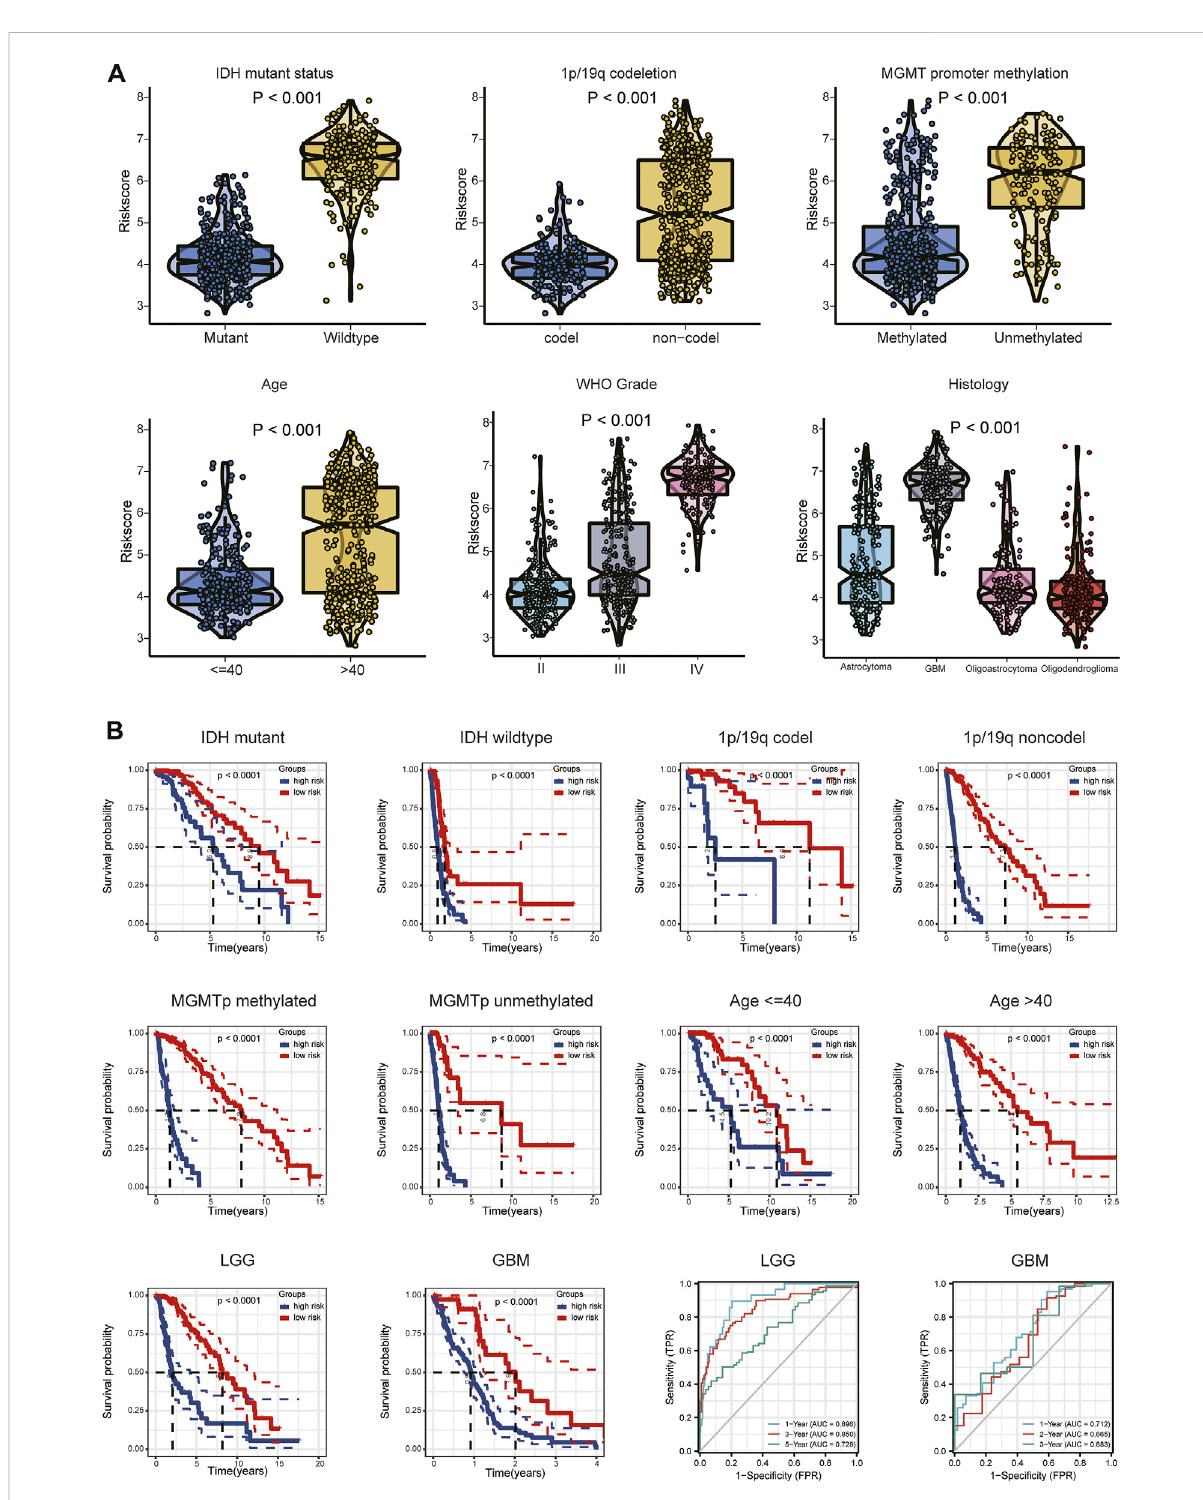
FIGURE 6 (A) Relationship between risk score and each clinicopathological characteristic ( IDH -mutant status, 1p/19q codeletion, MGMT promoter methylation, age, WHO grade, and histology). (B) KM analyses of patients in the CGGA dataset strati fi ed by IDH -mutant status, 1p/19q codeletion, MGMTpromotermethylation,age,andWHOgradeintheTCGAcohort.ROCcurveanalysisoftheriskmodelinpredicting1-,3-and5-yearOSinthe TCGA – LGG cohort and 1-, 2- and 3-year OS in the TCGA – GBM